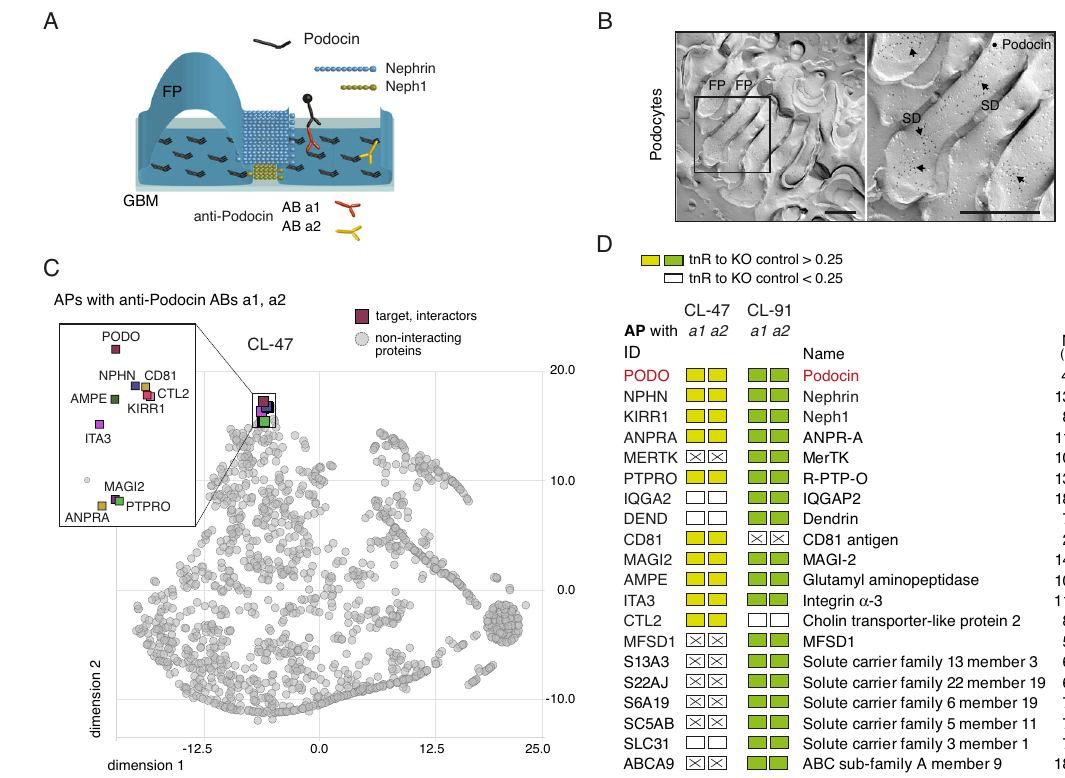
Fig.2|SubcellulardistributionandinteractomeofPodocininrenalpodocytes. A Epitope-localization of the anti-Podocin ABs used for meAP-MS analysis (further details in Supplementary Fig. 2). B Electron micrographs showing the distribution of Podocin proteins labeled by anti-Podocin AB a1 (and visualized by gold-particle coupled anti-IgG ABs, black dots) on the cytoplasmic side (P-face) of the plasma membrane in freeze-fracture replicas prepared from isolated glomeruli. Image on the right is the frame on the left at an expanded scale. Note that immuno-gold particles for Podocin (arrows) are observed close to the slit-facing membrane, as well as on the sole of the podocyte foot processes (FPs). Scale bars are 500nm. Micrographs are representative of at least four experiments. C t-SNE plot of